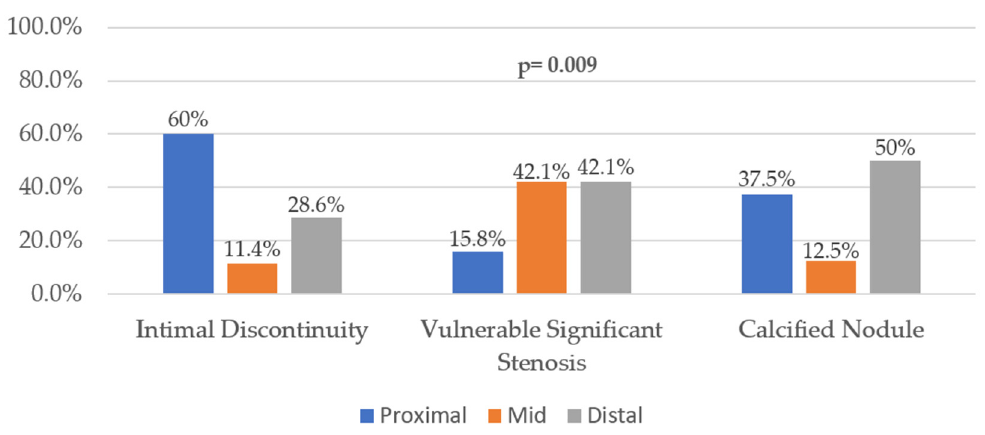
Figure 4. Topography of intraplaque complication.